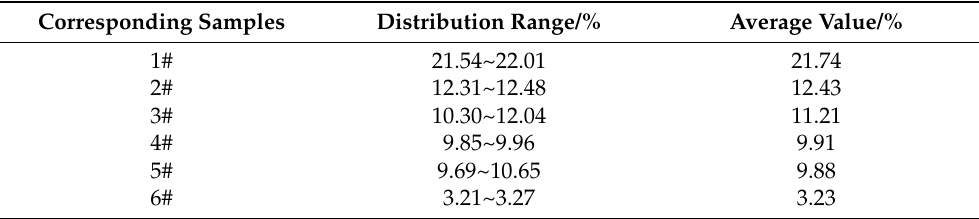
Table 3. Elongation at break of the corresponding filament for each sample. Corresponding Samples Distribution Range/% Average